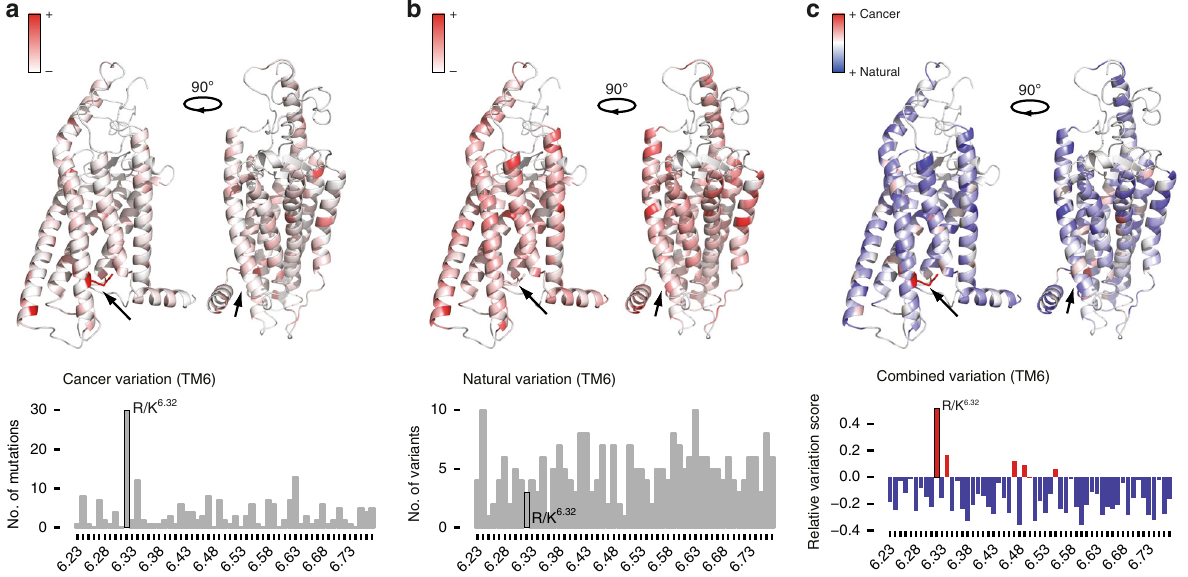
Fig. 1 A conserved, basic residue in TM6 of Class F receptors is frequently mutated in cancer. a Counts of cancer mutations in Class F receptors in human tumors. Color intensity corresponds to mutation frequency. b Counts of naturally occurring variants from gnomAD. c Relative variation score (see Methods) describing the amount of cancer variation compared to the variability observed in the natural population at each site. Positions where the amount of cancer variation is greater were colored in shades of red, whereas positions with excess of natural variation were colored in shades of blue. Panels a , b , c were generated by projecting sitewise scores onto a FZD 6 receptor model. For additional information on mutations in Class F in cancer see